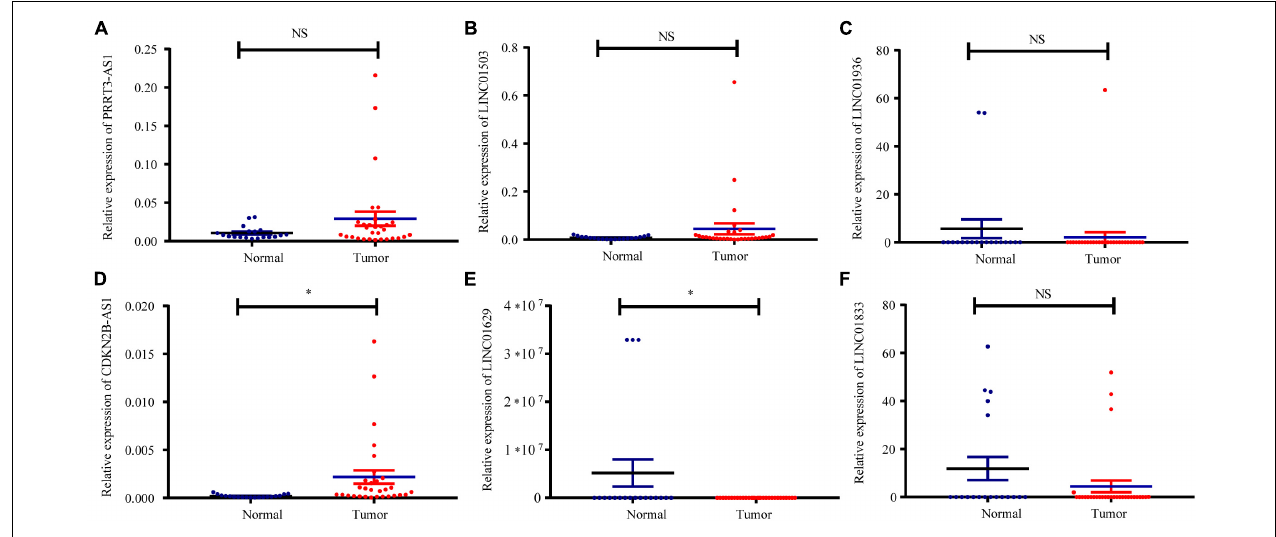
FIGURE 7 | Relative expression of immune-related lncRNAs in normal and UCEC tissues. Expression of (A) PRRT3-AS1, (B) LINC01503, (C) LINC01936, (D) CDKN2B-AS1, (E) LINC01629, and (F) LINC01833 in 30 EC tissues and 19 normal tissues determined using qRT-PCR. ∗ p < 0.05, NS, no statistical